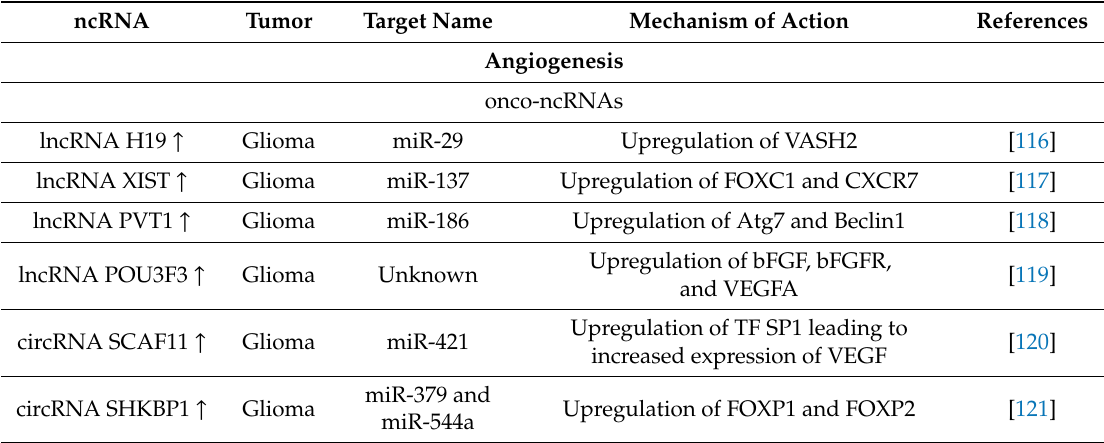
Table 2. Oncogenic lncRNAs and circRNAs involved in the regulation of